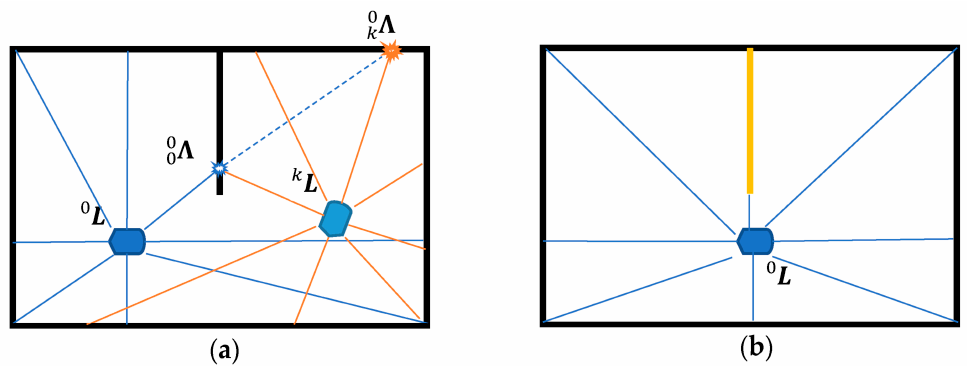
Figure 2. Example of ( a ) mapping conflict of a partitioned room, ( b ) unobservable